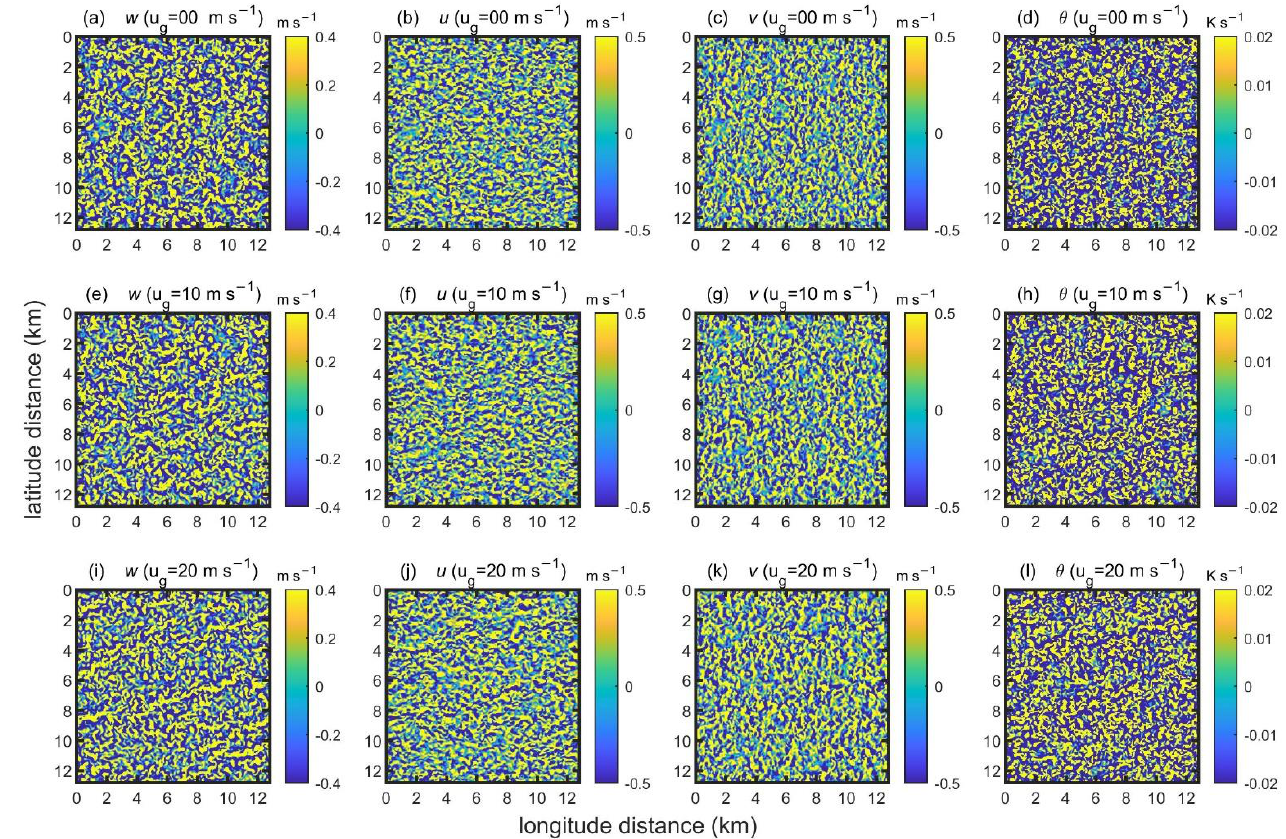
Figure 11. Filtered snapshots of w ( first column ), u ( second column ), v ( third column ), and θ ( last column ) from LES simulations at z / z i = 0.5 and 3 h of physical time with U g = 0 ms − 1 ( First row ), U g = 10 ms − 1 ( second row ), and U g = 20 ms − 1 ( third row ). D 0 is set as 9.375 × 10 − 4 m − 1 .